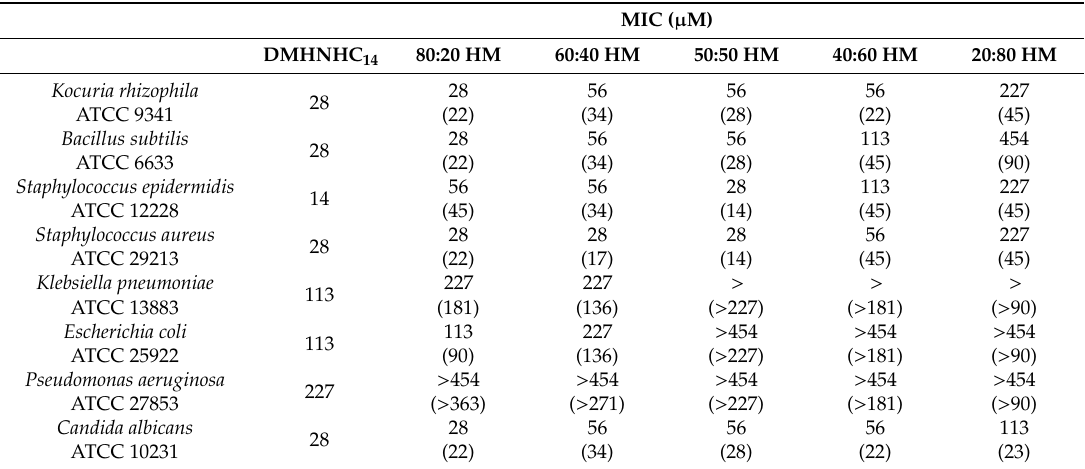
Table 3. Minimum inhibitory concentration (MIC) of the pure histidine derivative and its HM catanionic mixtures. Values in brackets correspond to the concentration of DMHNHC 14 in the catanionic formulations at their MIC values (MIC H ). The MIC values of sodium myristate were higher than 113 µ M for all microorganisms tested.